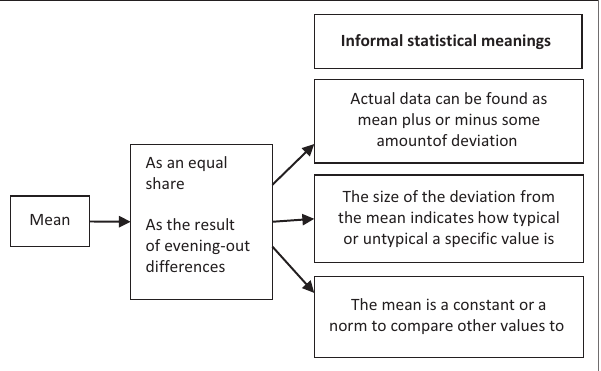
FIGURE 3: Informal statistical narratives on the meaning of the mean algorithm.